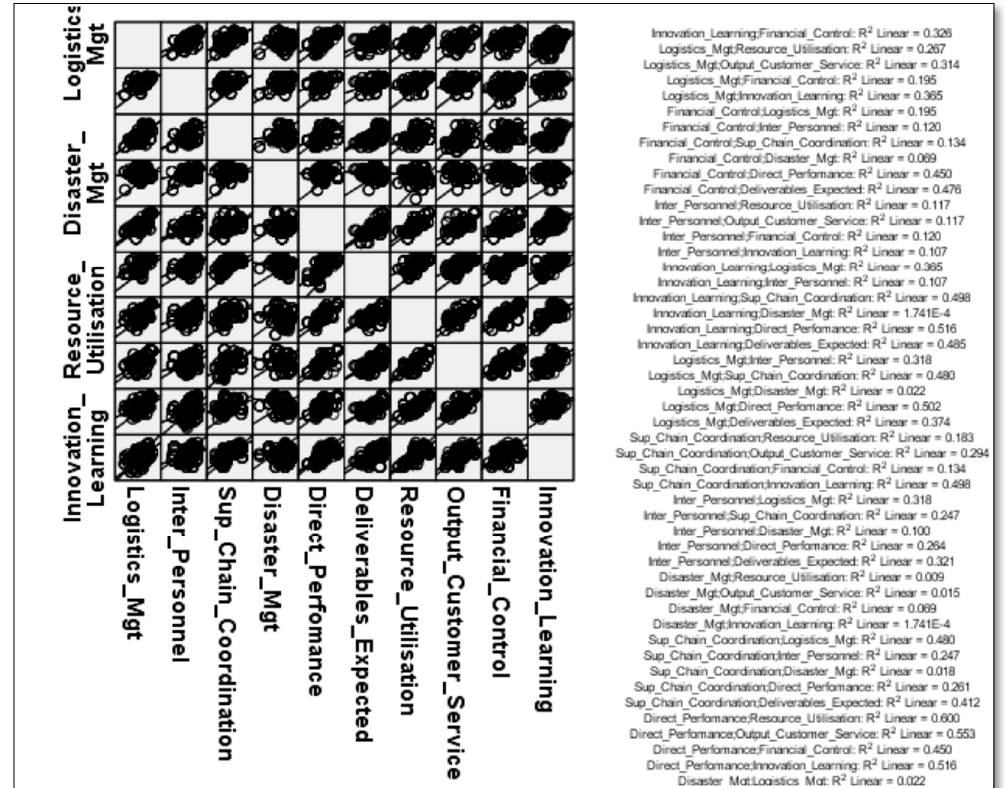
Figure 8. Linearity of each item used in the survey (Source: Survey data).